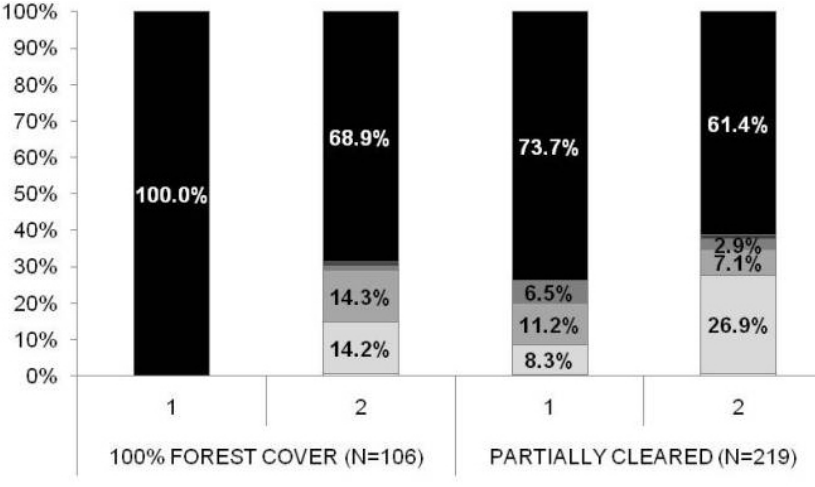
Fig. 5 . Percentages of vegetation-cover types in the properties of 83 households ( n = 325) for two points in time (1 = at the time of acquisition or occupation of the property, 2 = in 2008) grouped into two classes: (a) properties occupied with 100% forest cover (average time of ownership = 8.83 years [± 6.57]); (b) properties that had been partially cleared when acquired from previous owners (average time of ownership = 6.66 years [±